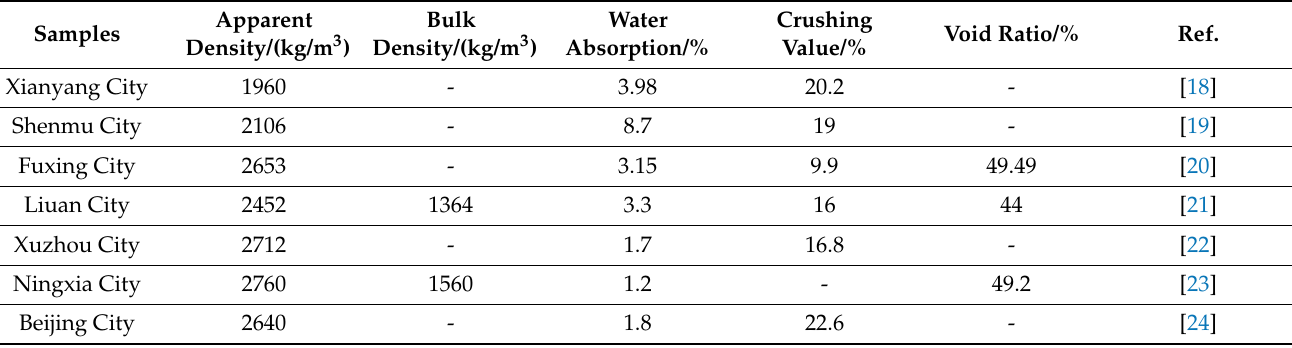
Table 1. Basic physical properties of coal gangue (rock coal gangue) from different locations in China.